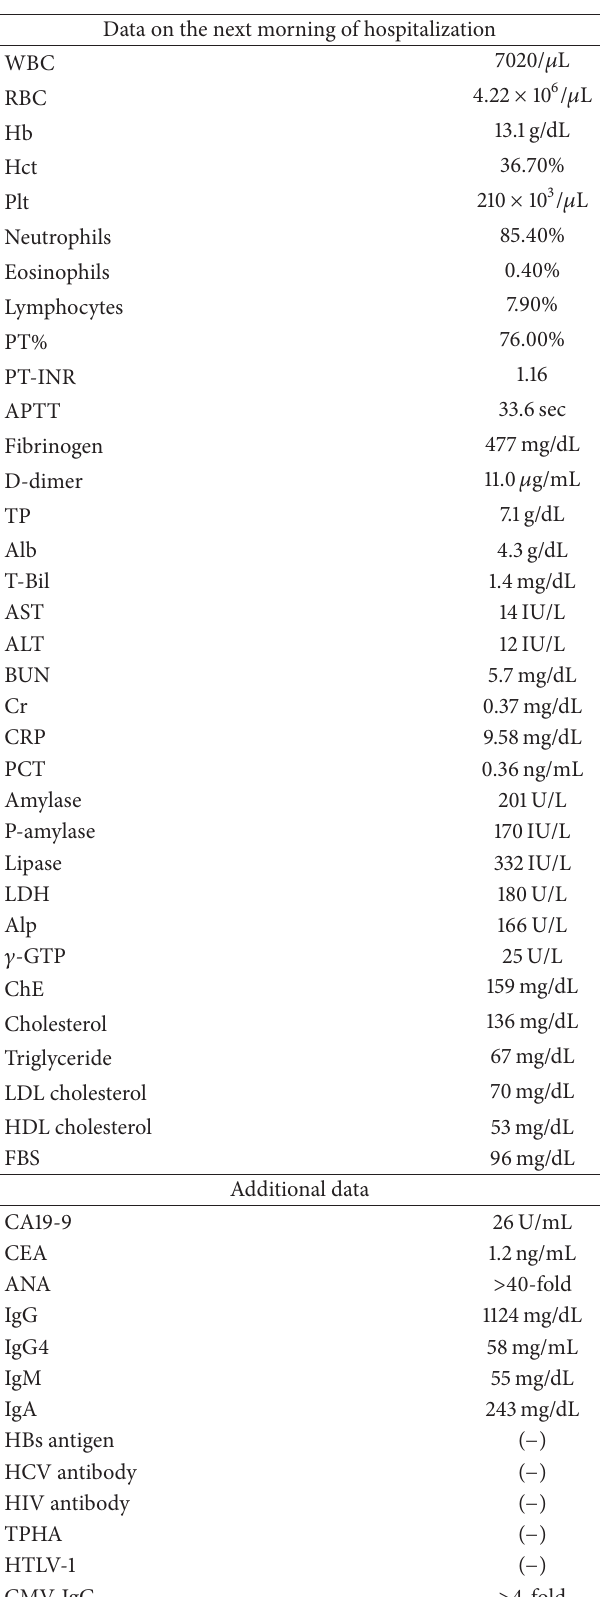
Table 1: Laboratory data of blood analysis on the next morning of hospitalization and additional data.